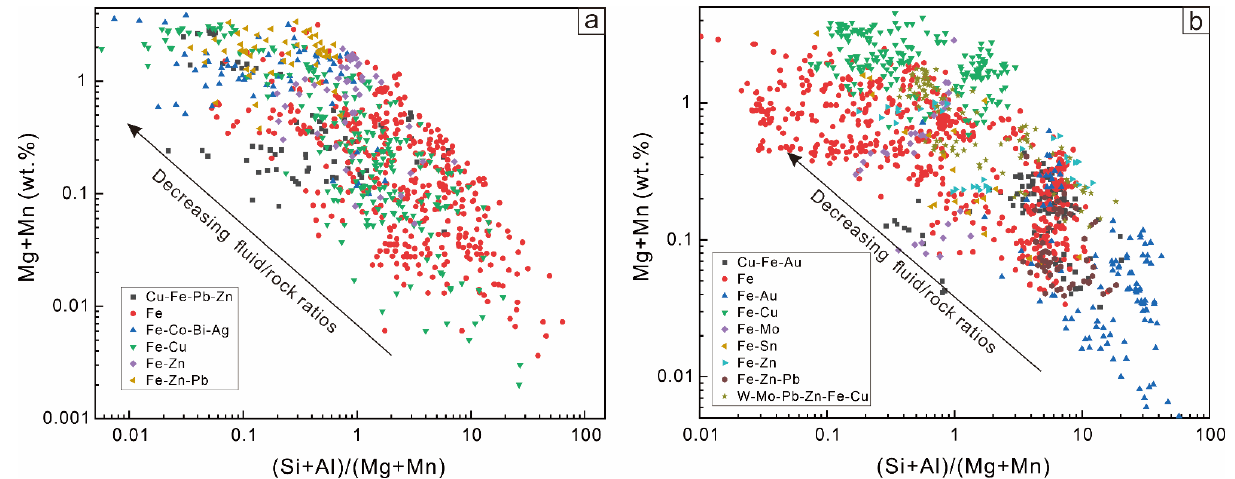
Figure 7. The plot of the EPMA ( a ) and LA-ICP-MS data ( b ) of magnetite in the (Si + Al)/(Mg + Mn) vs. Mg + Mn diagram proposed by Hu et al. (2014) [18]. The black arrows mean decreasing fluid/rock ratios.